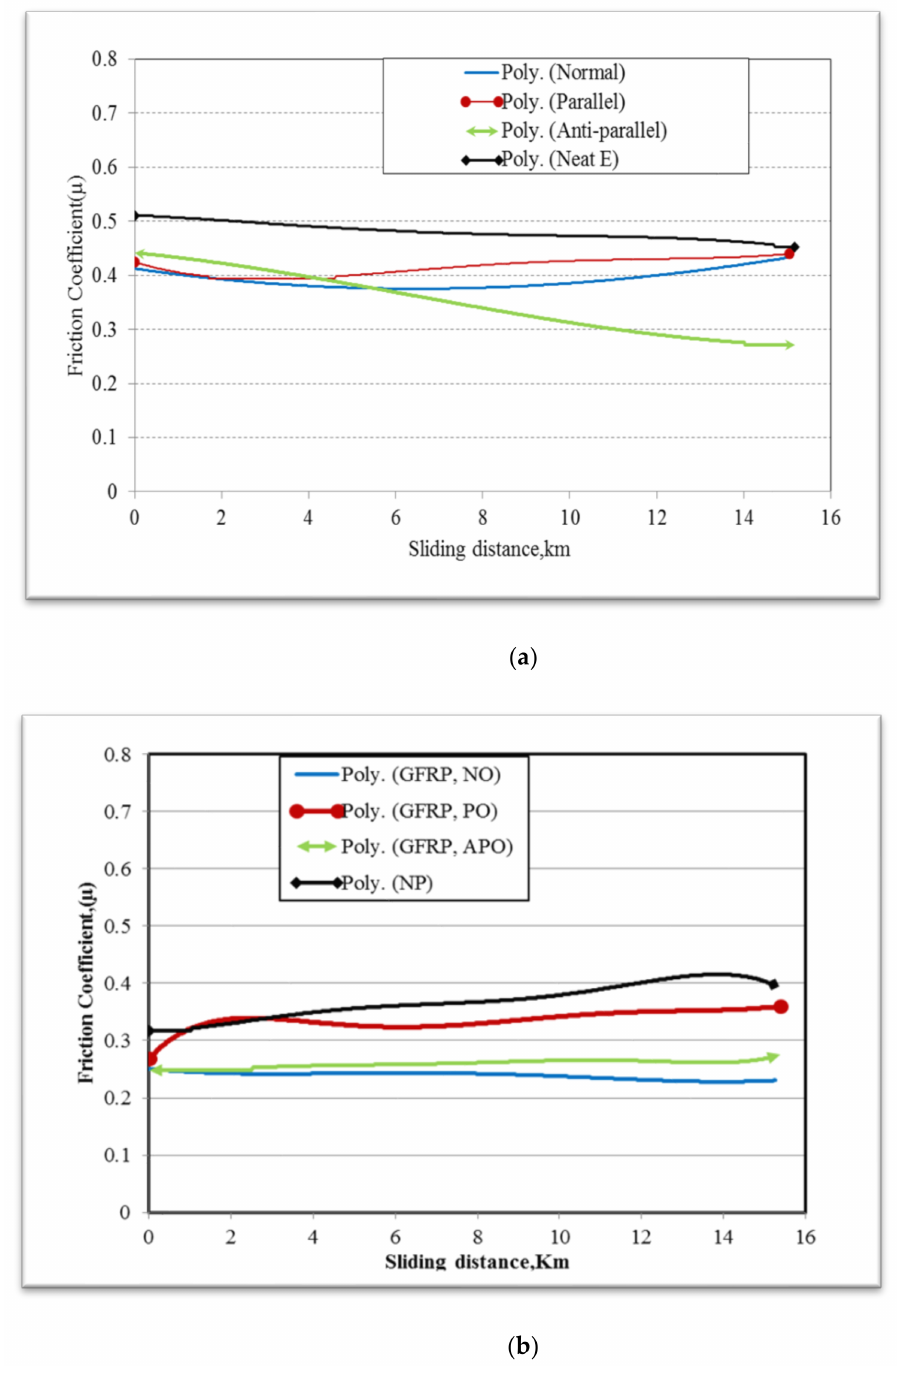
Figure 5. Friction coefficient of ( a ) GFRE and NE and ( b ) GFRP and NP. Figure 6 summarises the friction coefficients of all materials. The neat composites exhibited the highest friction coefficients at 10 km. Friction coefficients were also high for composites of different fibre orientations. However, the presence of fibres and strength of the interfacial adhesion prevents breakage and bending. Composites with AP–O fibres exhibited the lowest friction values. The friction value for GFRE with N–O fibres was higher than that of GFRP with N–O fibres. Of all fibre orientations for both composites, with AP–O fibres achieved the lowest friction